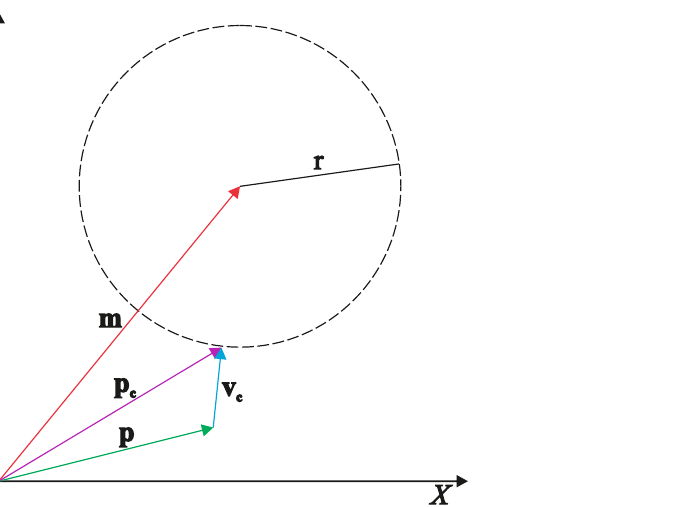
Figure 4. Determination scheme of position correction vector when one marker is detected.